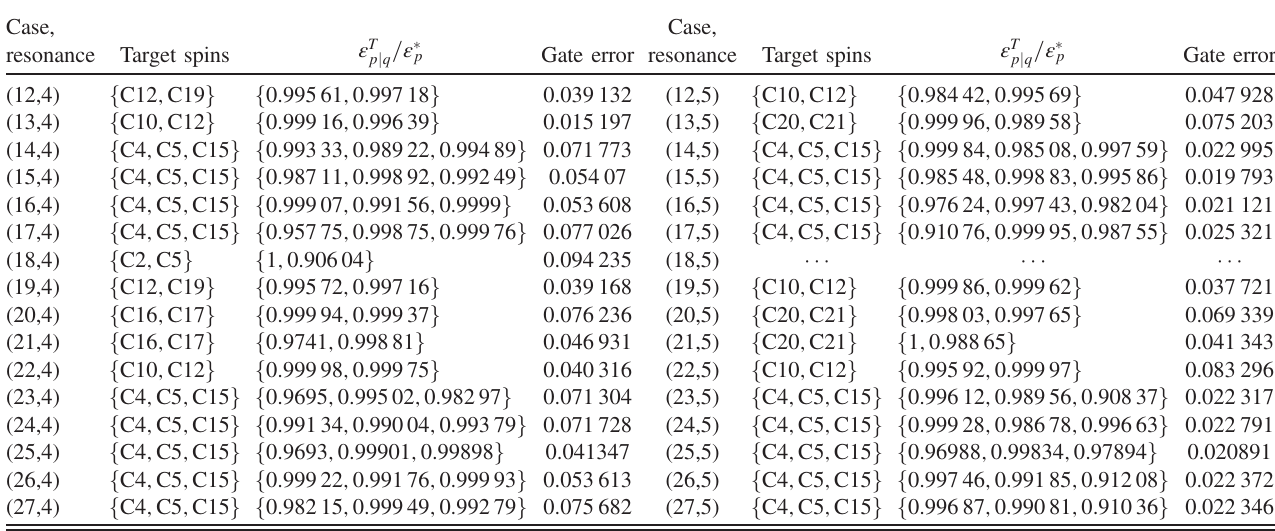
listed in Table X. The rotation angles and axes for the sequential and multispin gates in Fig. 9 are